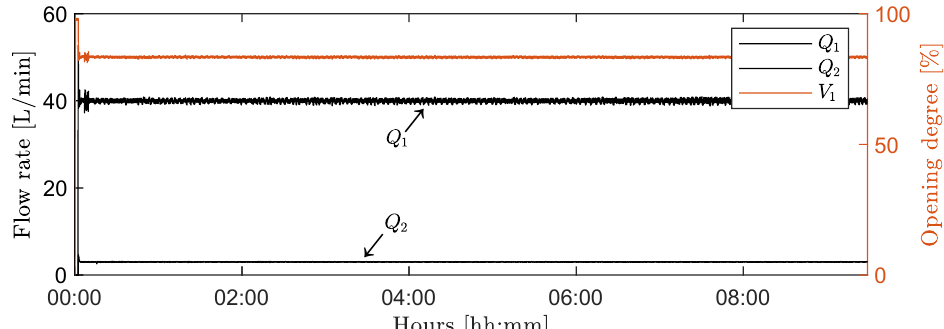
Figure 11. Flow rates from Q 1 , Q 2 , and the opening the degree of V 1 to maintain a constant flow rate through the sidestream of the entire ∼ 9.5 h experiment.